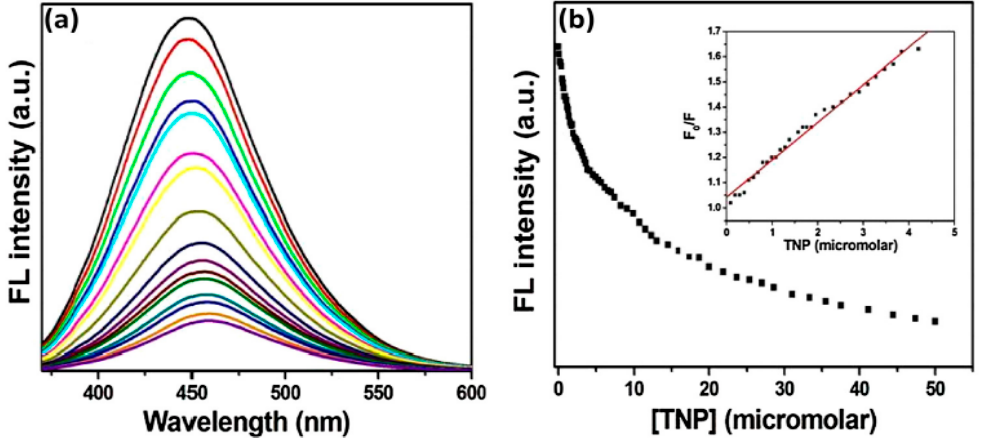
Figure 3. ( a ) FL behavior of N-GQDs in the presence of various TNP concentrations (from top to bottom (0–50 M)). ( b ) FL emission curve of N-GQDs with increased concentration of TNP (inset: Stern–Volmer plot for the quenching process) [59].